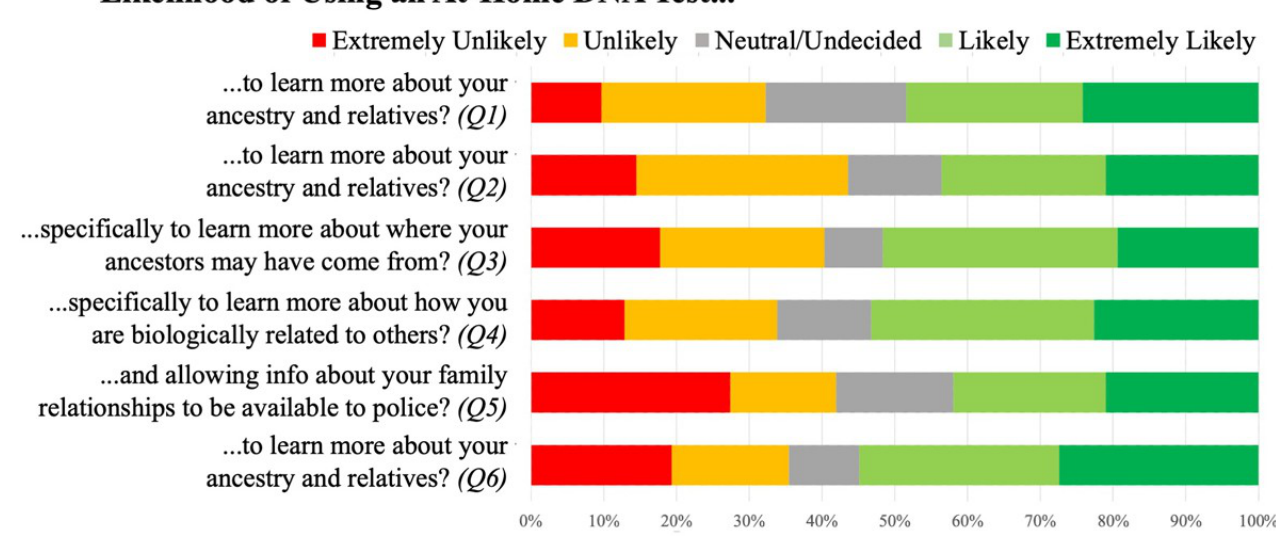
Fig 1. Participant worksheet responses. Questions correspond to the closed-ended questions asked throughout the focus groups (S3 Appendix). Q1 corresponds to the start of the focus group, prior to any educational materials.